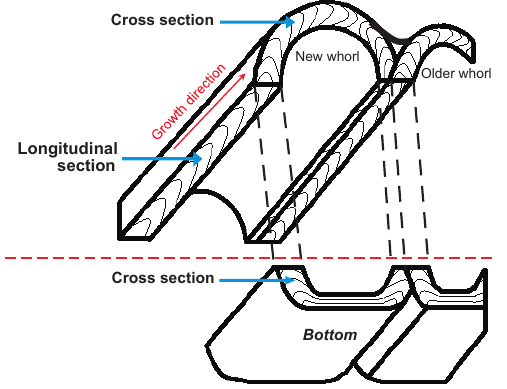
Figure 8. Schematic line drawing of the shell structures of S. spiror- bis showing the orientations of cross and longitudinal sections (blue arrows) and the respective orientation of the chevron lamellae. Red arrows indicate growth direction. The parts below the red dashed line are only visible in the longitudinal sections. Tube wall thick- ness is about 100µm. Table 2. Corroded sample percentages (%) and number of corroded specimens ( n ).